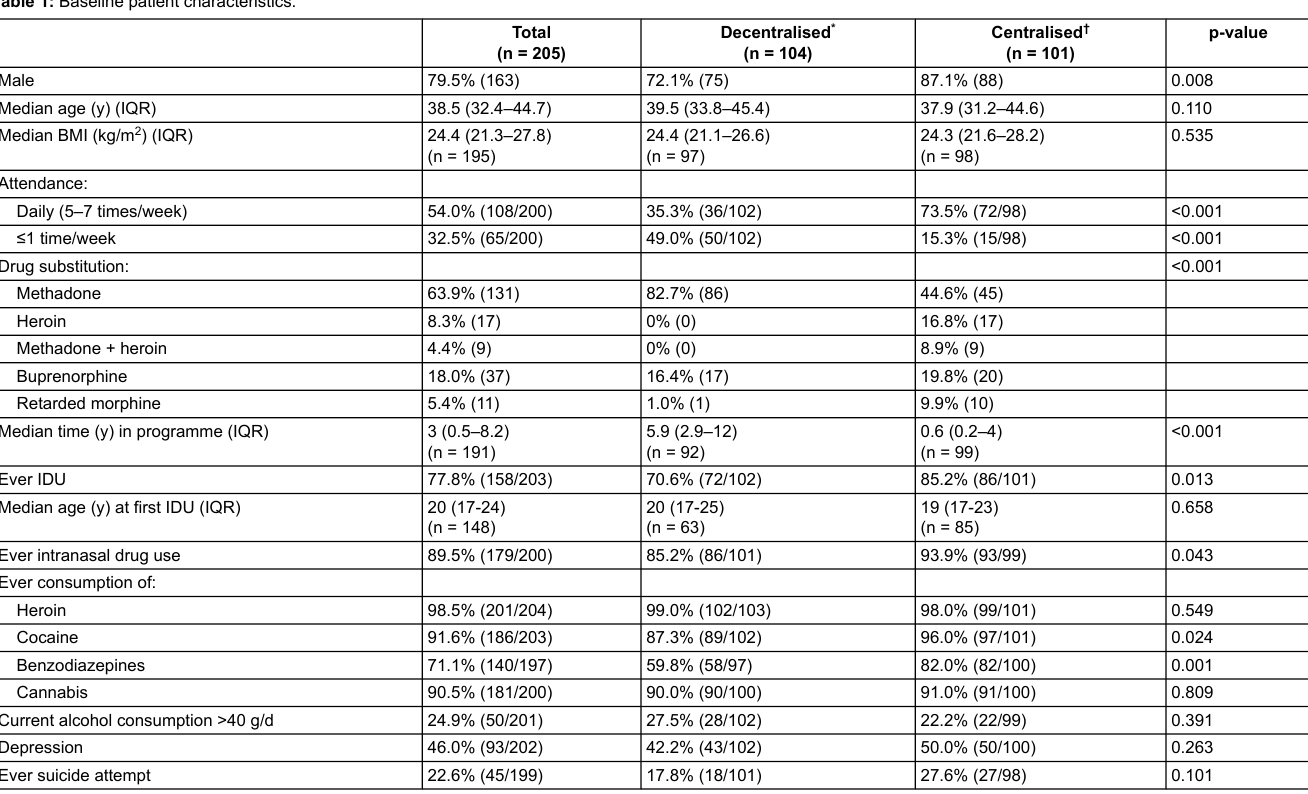
Table 1: Baseline patient